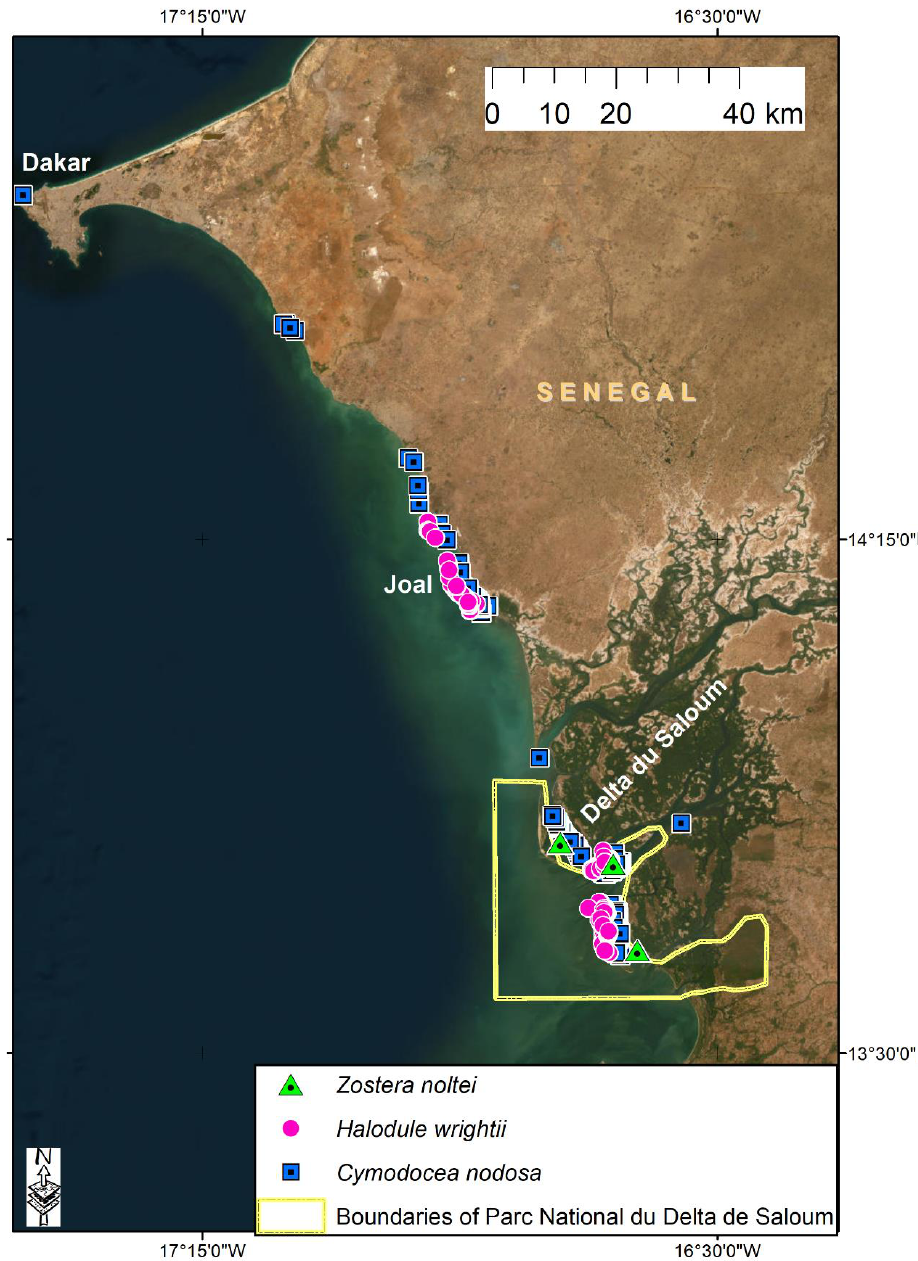
Figure 1. Seagrass distribution in Senegal. The southernmost limit of Z. noltei is indicated by the green symbol within the areas of Saloum Delta National